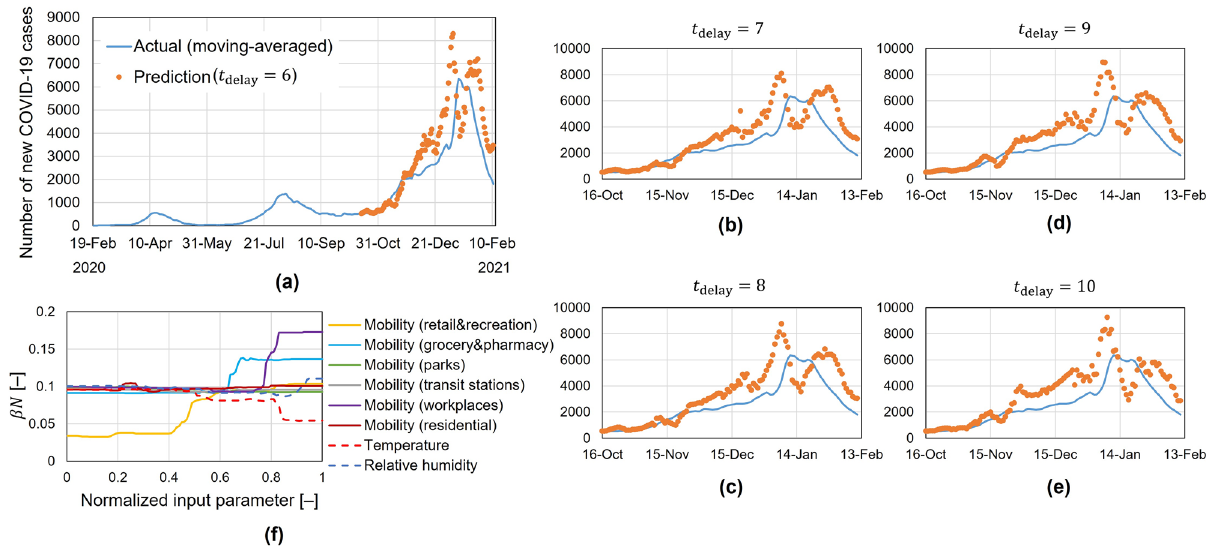
Figure 2. Forecast and analysis results of the number of COVID-19 cases in Japan. Forecast results using a t delay of ( a ) 6 days, ( b ) 7 days, ( c ) 8 days, ( d ) 9 days, ( e ) 10 days. Forecasting started on 16 October 2020 using the data from 21 February to 15 October 2020 for model development. ( f ) Sensitivity analysis to quantify the impacts of mobility, temperature, and humidity on the infection rate β . The random forest model used was developed using the simple moving average data for mobility, temperature, and humidity from 21 February 2020 to 11 February 2021 as training data. Each input parameter was changed from the minimum to the maximum of the training data, and the other input parameters were fixed as the mean values for the training data. The horizontal axis in the graph is the normalized value of input parameters, where the minimum and the maximum were normalized as 0 and 1, respectively. The vertical axis represents the product of the infection rate β and population N with the predicted β ( t ) as an input. The prediction of β ( t ) started from 16 October using mobility data from 6 days ahead (10 October). The predicted infection rates on a certain day β ( t ) was used to forecast the number of cases on the next day at ( t + 1). The initial training set (from 15 February to 15 October 2020) was updated daily afterwards for further predictions of β ( t ), thus enabling forecasts of t delay + 1 day-ahead. Comparing the forecast results using different values of t delay up to 10 days showed that the prediction could follow the general trend of the number of new cases (Fig. 2), but with forecast errors becoming larger with increasing t delay , especially around the peak of the third wave. Predicted case numbers using models with t delay of 6–10 days showed the start of the third wave in November 2020. Prediction of the magnitude and timing of the peak varied between the models. Forecasted peak values were slightly higher than the actual (between 27 and 46% for t delay of 6–10 days). On the other hand, the timing of both the peak and the start of the decrease in the number of cases was more accurately predicted (3–5 days difference between the actual and predicted peak times for t delay of 6–10 days). Figure 2f shows the impact of different input parameters on the general infection rate β throughout the entire period (not time-specific). The parameters with the highest influence were determined as: mobility in retail and recreation, in grocery shops and pharmacies, and in workplaces, in addition to the temperature. Gaps between prediction and actual recorded cases around the third wave result from multiple factors including, changing behaviour from the previous training set with the onset of a new season (lower temperatures in December and January than the training set, which starts in February) or special holidays around the new year which shifted patterns of mobility (Supplementary Fig. S2) and changes in the number of conducted tests. Forecasts in the four prefectures. We applied the same method to the data from the four prefectures: Tokyo, Osaka, Hokkaido, and Fukuoka, which were selected because of their diversity in geography and climate, population, and the number of COVID-19 cases. Tokyo and Osaka have a higher population density than Hok- kaido and Fukuoka. Hokkaido has a different climate being further up north with much colder winters, and milder summer temperatures. The forecast results with different t delay values 6 days and (7–10 days) are presented in Fig. 3 and Supplementary Fig. S3, respectively. The model could predict the number of cases in all four prefectures despite the variation in climate, popula- tion, and the number of COVID-19 cases (Fig. 3). This suggests that the critical underlying factors have been accounted for in the model, and its application could thus be extended to other areas. The sensitivity of the infection rate to changes in mobility patterns, temperature, and humidity for the four prefectures is presented in Supplementary Fig. S4.